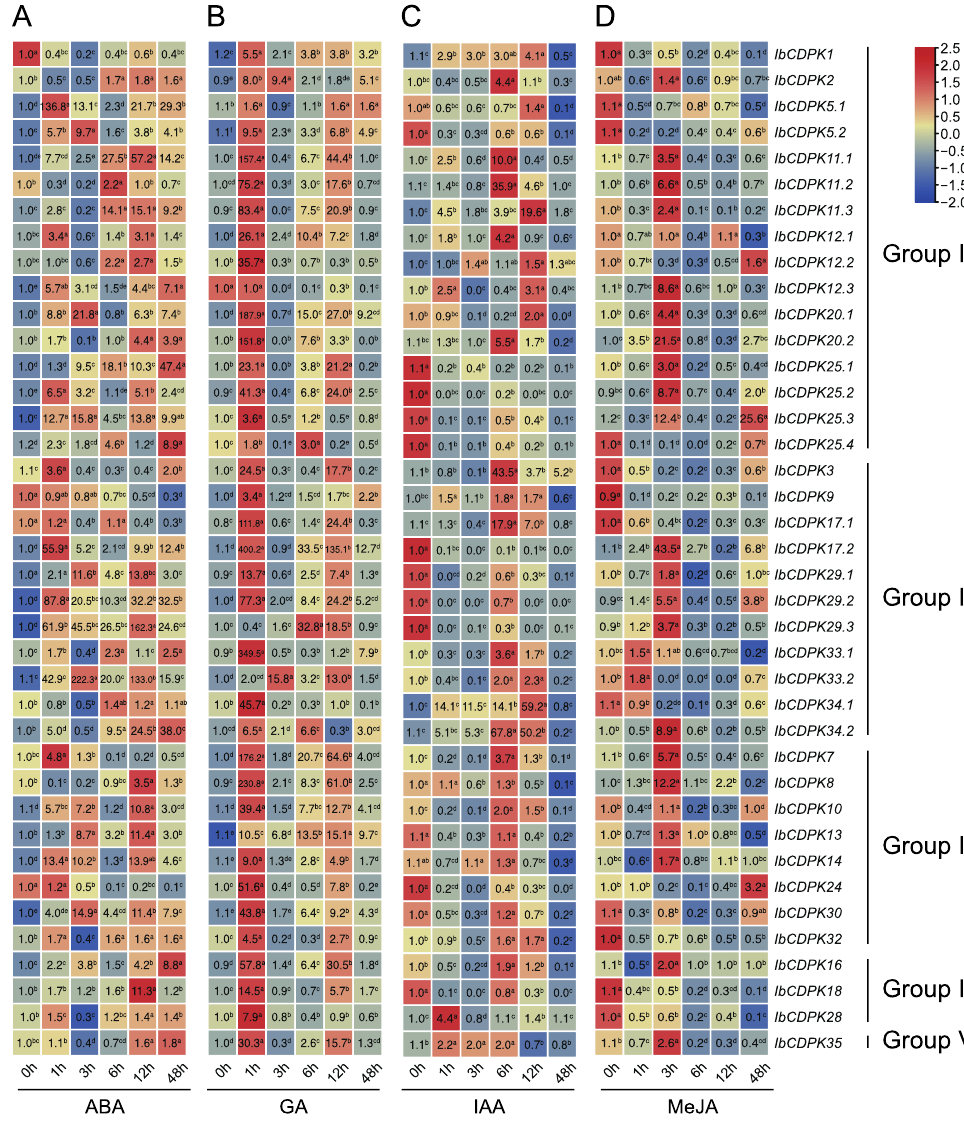
Figure 8. Gene expression patterns of IbCDPKs in response to different phytohormones, i.e., ( A ) ABA, ( B ) GA, ( C ) IAA, and ( D ) MeJA of I. batatas. The values were determined by RT-qPCR from three biological replicates consisting of pools of three plants, and the results were analyzed using the comparative C T method. The expression of 0 h in each treatment was considered “1”. The fold change is shown in the boxes. Different lowercase letters indicate significant differences ( p < 0.05; Student’s t